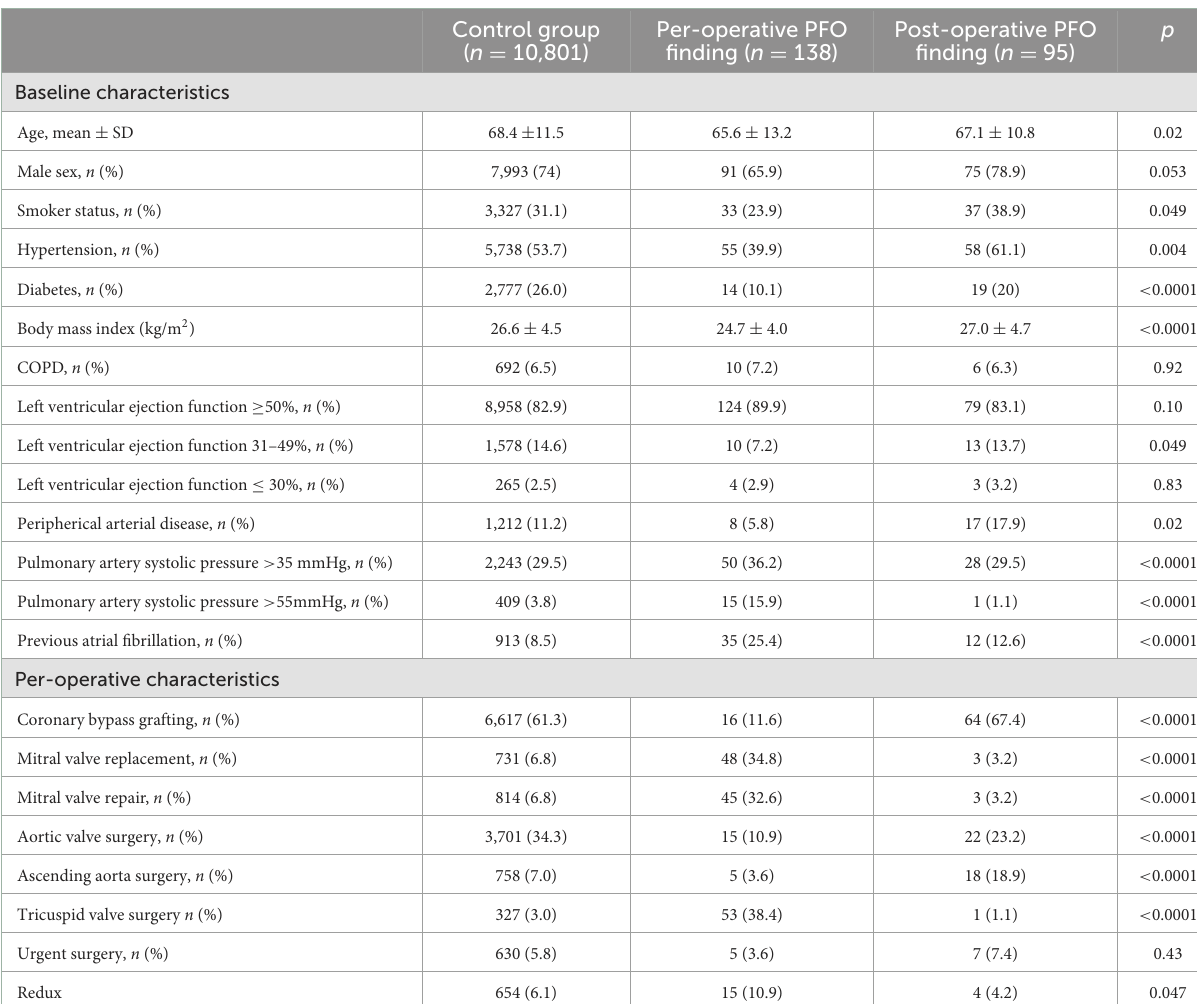
TABLE 1 Baseline and pre-operative